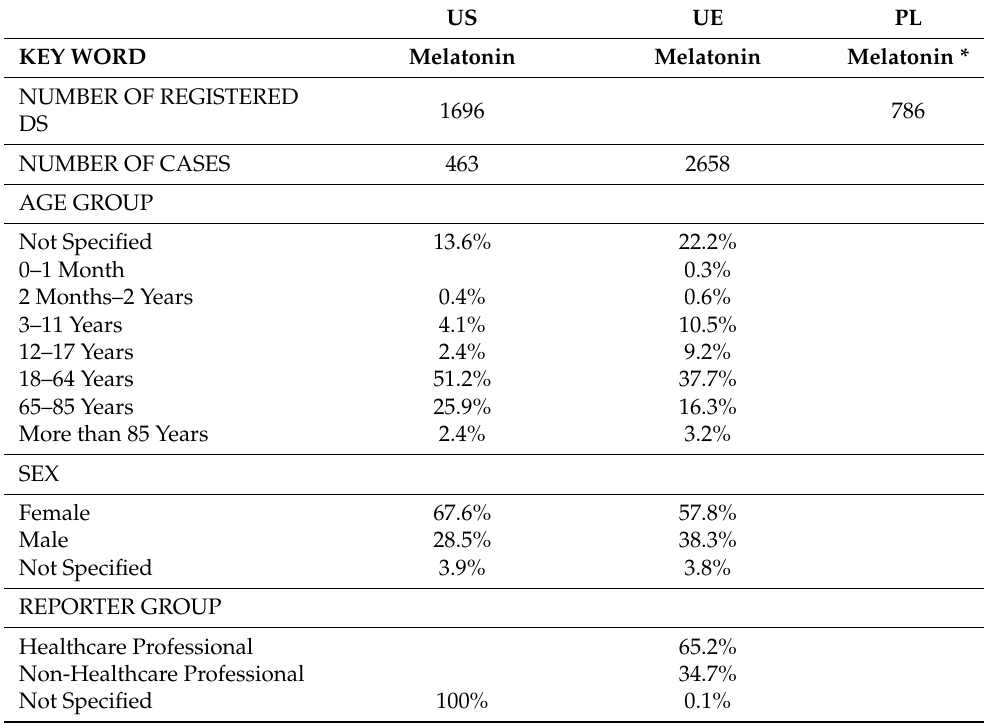
Table 2. Comparison of data on Melatonin from different